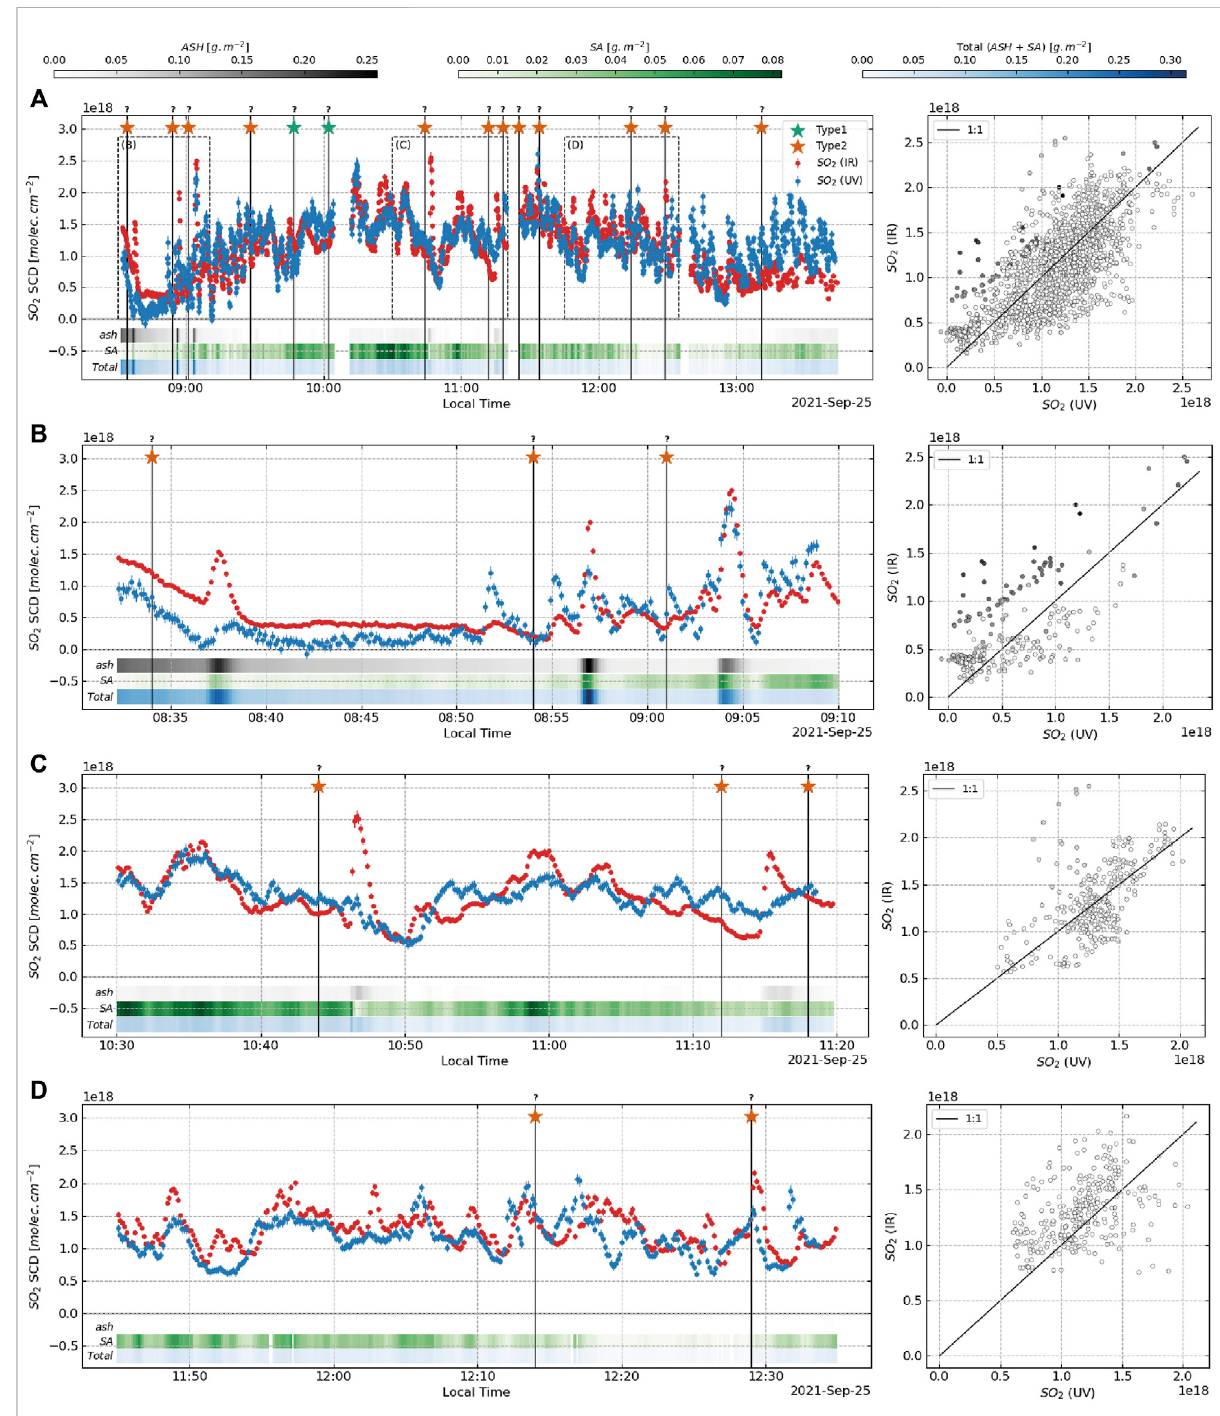
FIGURE 8 Time series of SO 2 SCDs measured on 25 September 2021. SCDs retrieved from the IR dataset are shown in red. SCDs retrieved from UV measurements are shown in blue. The UV time series was resampled after cross-correlation and has been shifted by 71 s to correct for the misalignment between the telescopes. Also shown are the mass SCDs for ash [grey], sulphate aerosols [SA, green] and total particulates [blue]. Stars represent individual events, recorded at the time when a plume is visible over the crater rim in video footage. Inset on the right shows a scatter plot between UV and IR SCDs, and the datapoints are coloured according to the retrieved ash SCD. Time and y -axis scales change between panels, but colour scales remain the same (A) Full dataset. Zoom windows for subsequent panels are shown as dashed boxes. Note that systematic disagreementbetweenUV and IR retrieval occur towards thebeginning and end ofthe measurementperiods (B) Zoom window showing three ash-